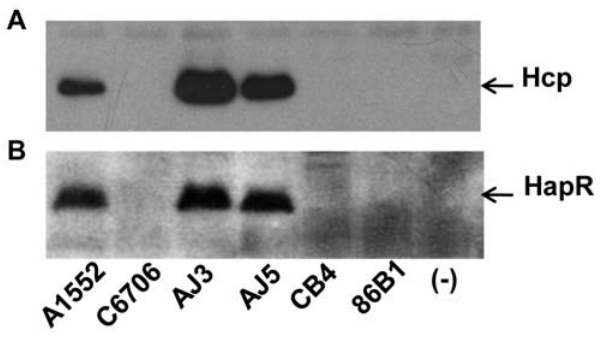
Figure 6. Levels of Hcp and HapR in different V.cholerae O1 isolates. (A) Immunoblot analysis of the expression of the Hcp in different V. cholerae O1 isolates was performed using anti-Hcp antiserum. (B) Detection of the HapR protein in same samples used for the detection of the Hcp. Samples were taken at OD 2.0. (-); negative controls for Hcp ( D hcp 1,2) and HapR ( D hapR )